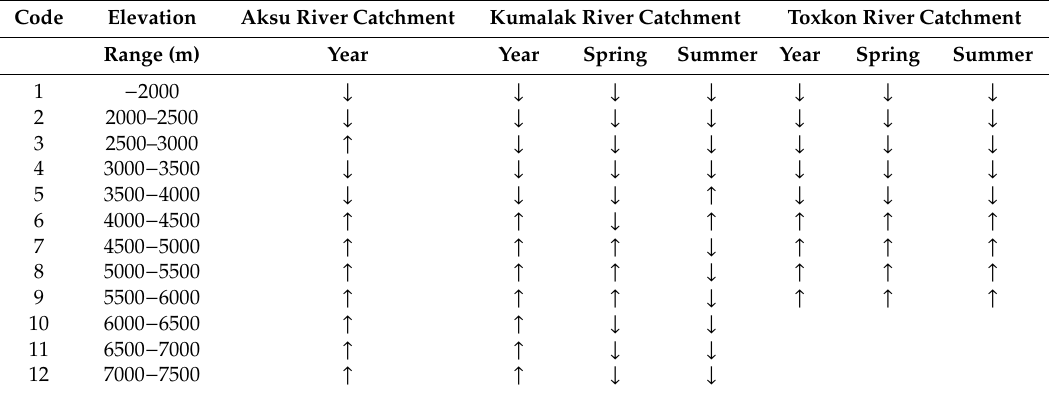
Code Elevation Range